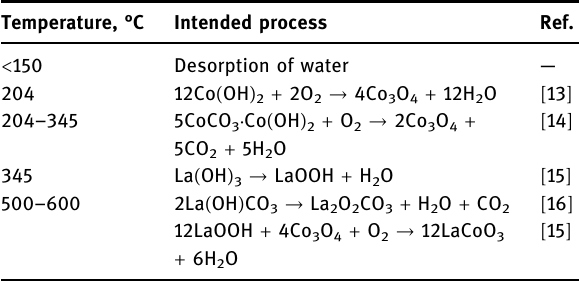
Table 1: Observed thermal e ff ects for the precursor sample LCO -